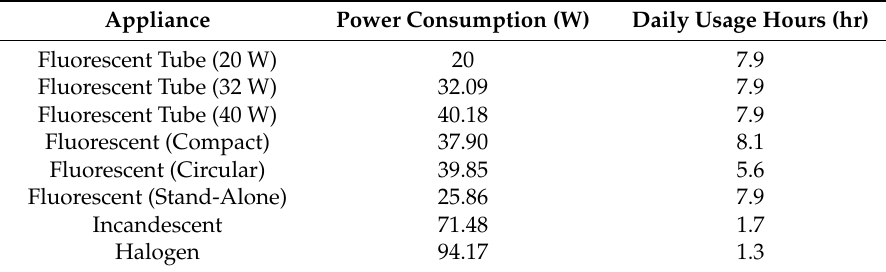
Table 5. Power consumption of lighting